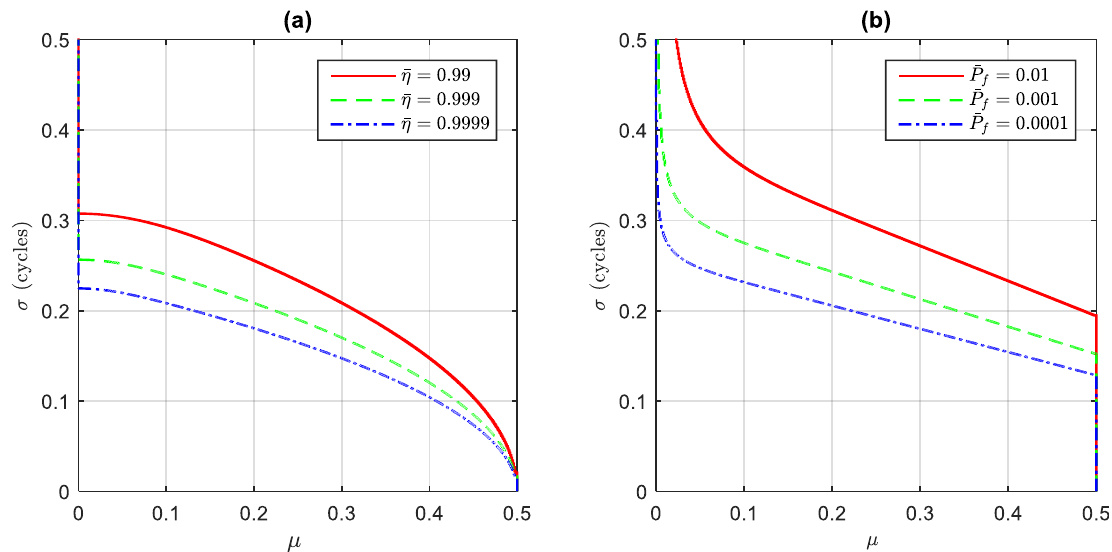
Figure 5. Illustration of the relationship between the acceptance region size and model strength of the FL-approach ( a ) and the FF-approach ( b ).